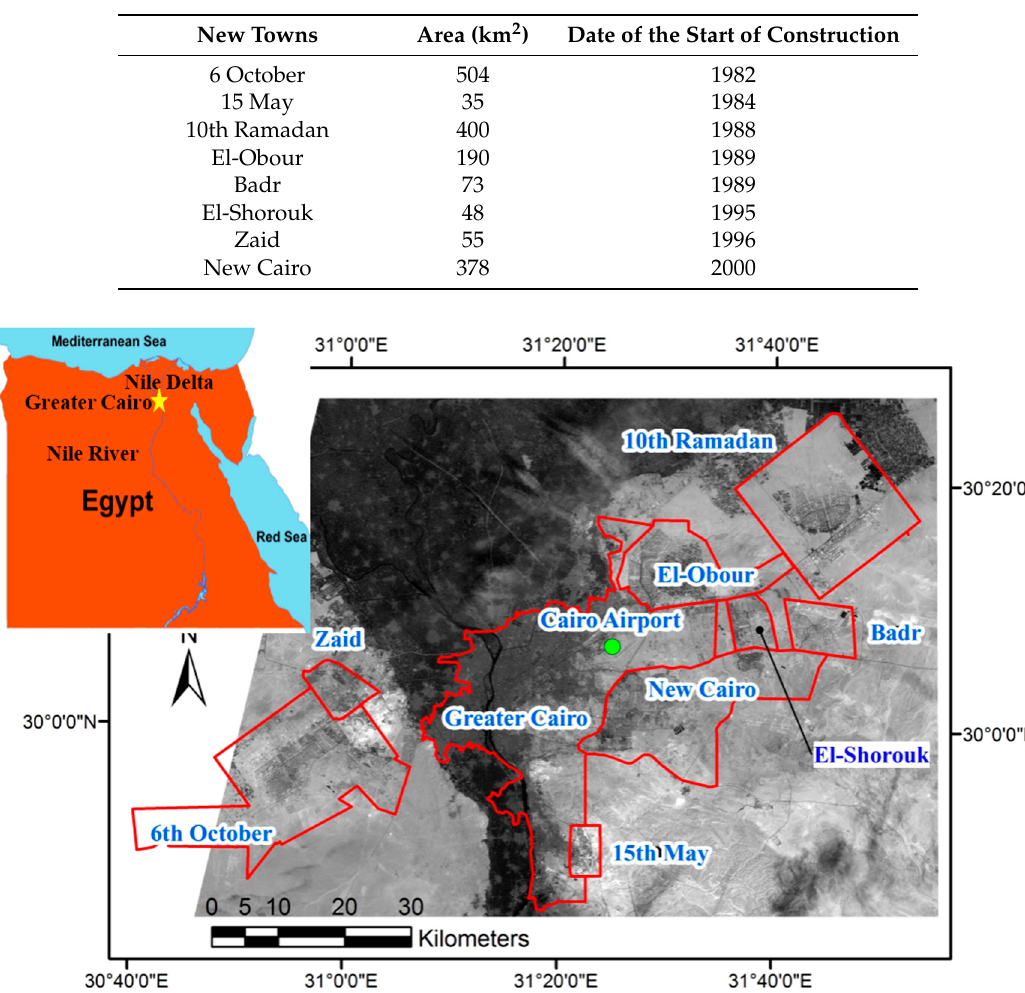
Table 1. The eight new towns founded near Cairo, with their characteristics.